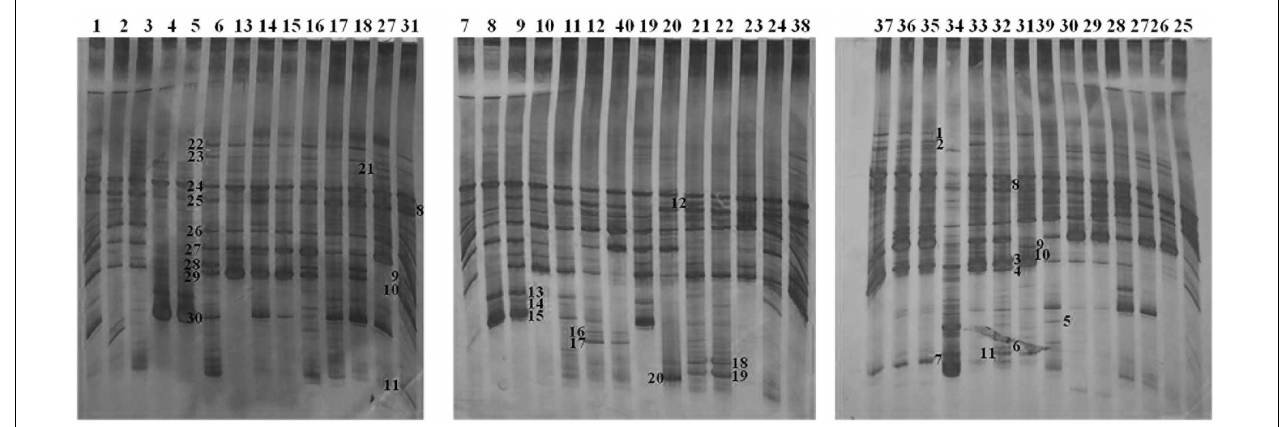
FIGURE 1 | Denaturing gradient gel electrophoresis profiles of rDNA amplicons obtained using a Lactobacillus- specific primer set on bacterial DNA isolated from fecal tissue samples of AO and DA rats. Each lane represents sample of an individual rat. Total of 40 samples (20 from each of the strains) was analyzed. Distribution of samples between the strains and among different time points is presented in Figure 2 . Bands indicated by numbers (1–30) were excised, cloned, and